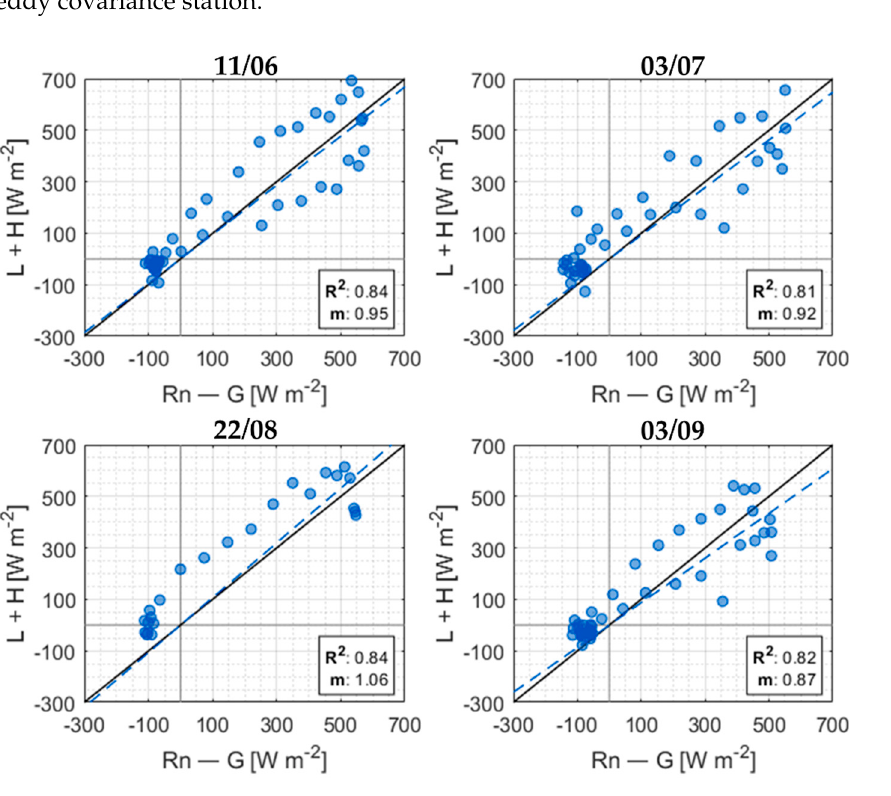
Figure A3. Energy balance closure check for the eddy covariance data on the four available dates. Turbulent energy (L + H) against Available energy (Rn–G).